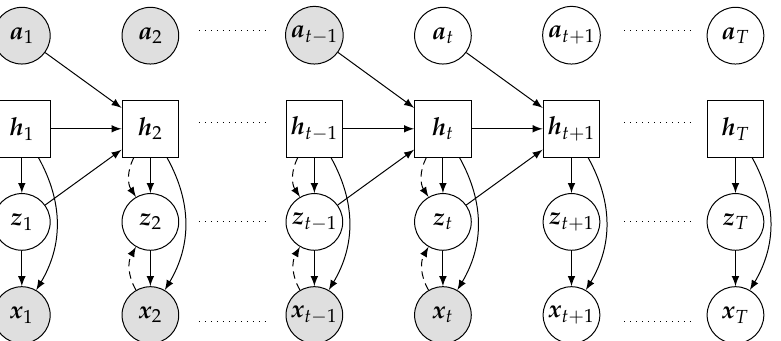
(2) representation model ˆ z t ∼ q ( ˆ z | h t , x t ) and (3) transition predictor ˜ z t ∼ p ( ˜ z | h t ) , where h represents the deterministic latent representation of state s , ˜ z represents the prior of the stochastic latent state and ˆ z is the posterior induced by the deterministic latent state h and the current observation x .